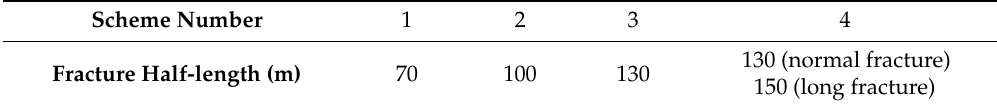
Table 12. Fracture half-length in different schemes.